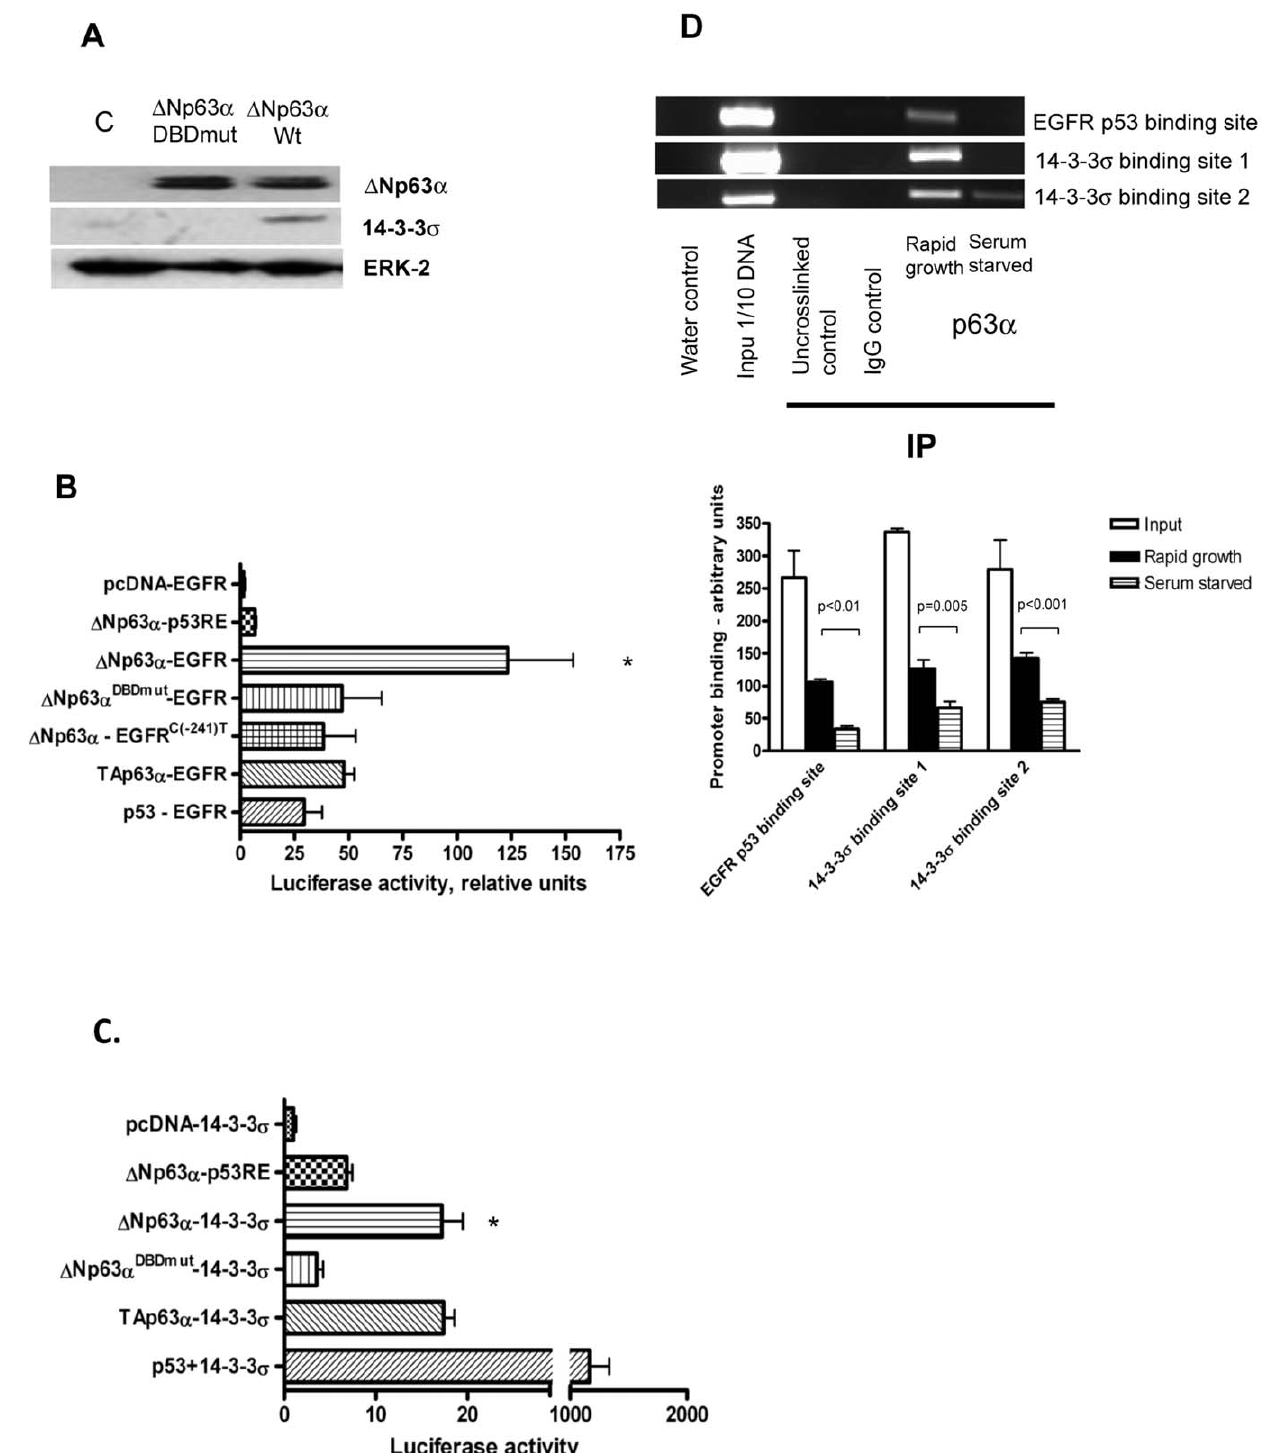
Figure 6. D Np63 a is a transcriptional activator of EGFR and 14-3-3 s in pancreatic cancer cells. A , D Np63 a DBDmut does not upregulate 14- 3-3 s . B and C , D Np63 a upregulates EGFR and 14-3-3 s promoter in a luciferase assay. PANC-1 cells were transfected with wildtype EGFR, mutant EGFR or 14-3-3 s promoter luciferase construct as indicated, along with pCMV b plasmid, with or without wildtype p53, D Np63 a , D Np63 a DBDmut , or TAp63 a . At 48–72 h after transfection, the luciferase activity was determined. The transfection efficiency was standardized against b -galactosidase activity. Results are indicative of four independent experiments. *, p , 0.0001. D , p63 binds EGFR and 14-3-3 s promoters in T3M4 cells. Binding is decreased upon serum-starvation. T3M4 cells were grown in medium containing 10% FBS (rapidly growing cells) or in serum-free medium (predominantly resting cells). Cells were pelleted and ChIP was performed as described in materials and methods. Uncrosslinked protein lysate, protein lysate immunoprecipitated with an irrelevant antibody, and a protein lysate immunoprecipitated with p63 antibody, but where irrelevant DNA sequences located , 3000 bp downstream of the 14-3-3 s or EGFR promoter regions were amplified served as negative controls (the latter not shown).